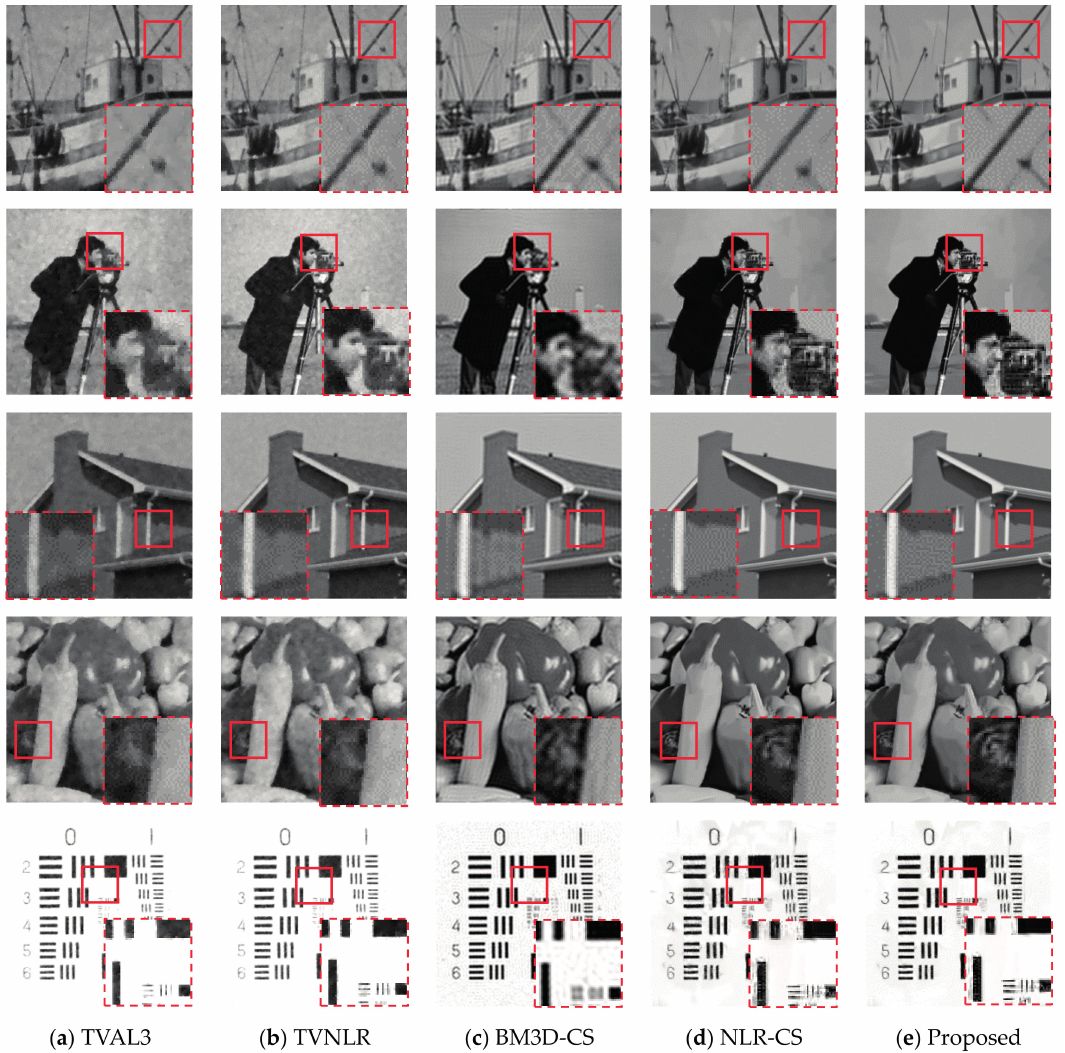
Figure 5. Comparison of reconstruction results of five test images with ( a ) TVAL3, ( b ) TVNLR, ( c ) BM3D-CS, ( d ) NLR-CS, ( e ) Proposed algorithm at 10% sampling rate. The lower right or left corner of the image is the selected local detail